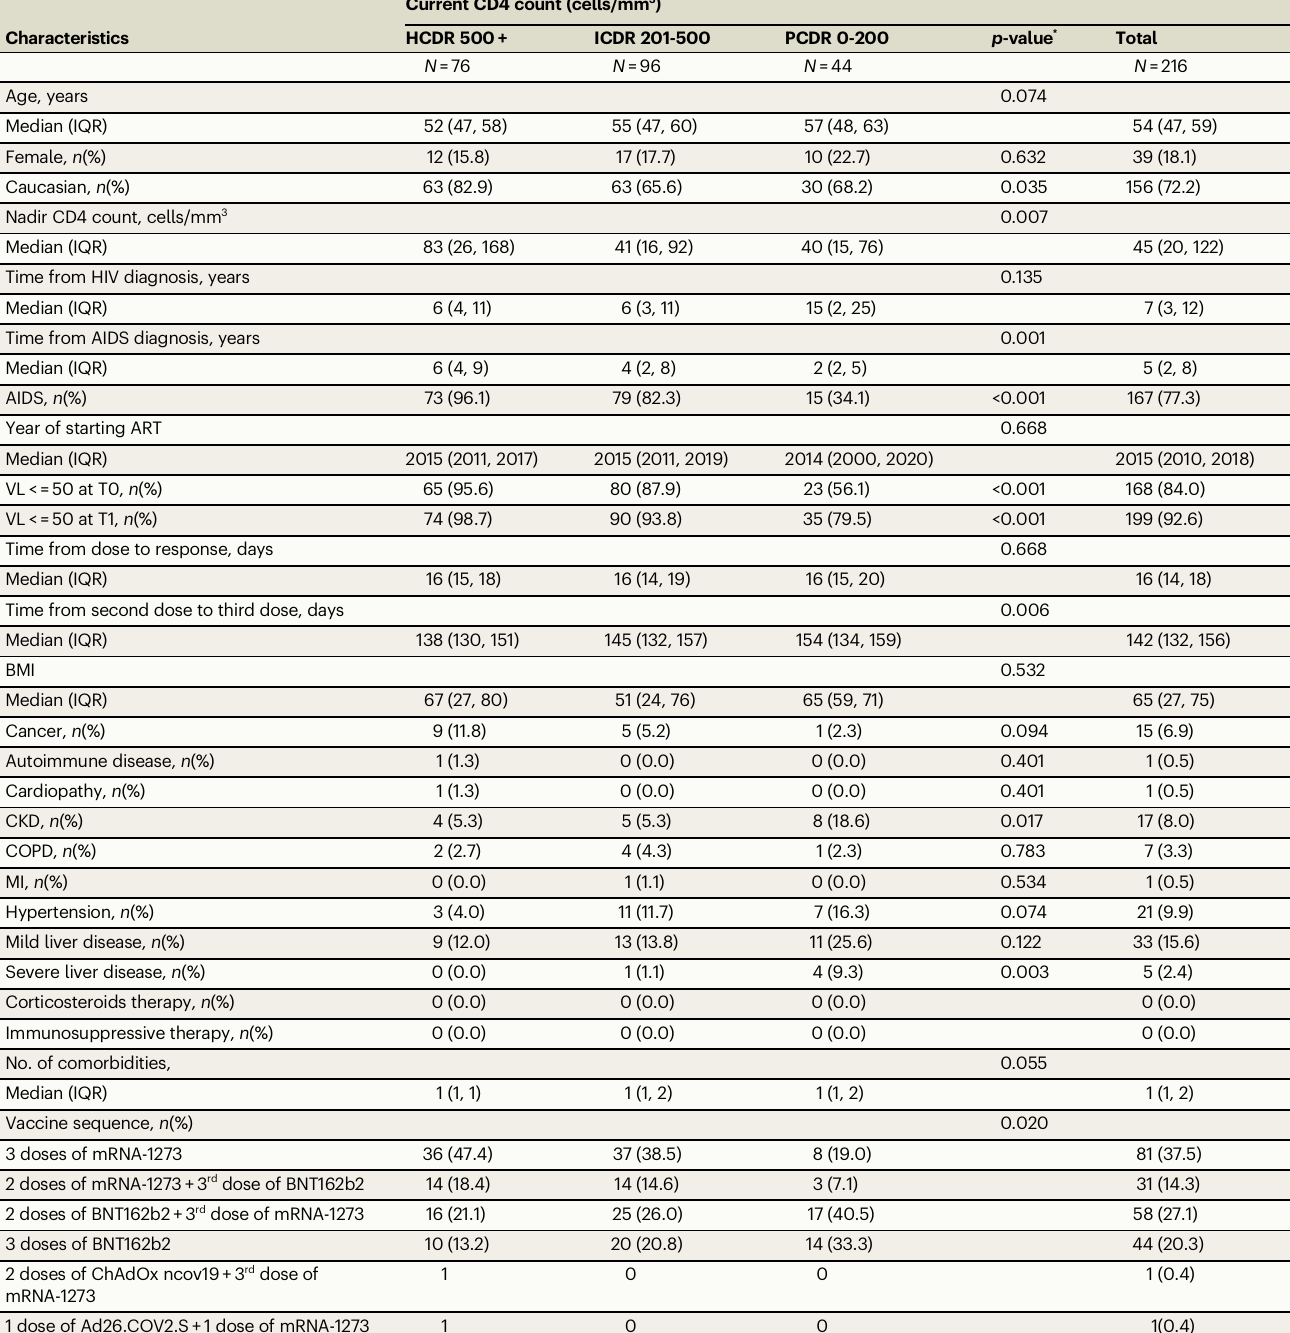
Current CD4 count (cells/mm 3